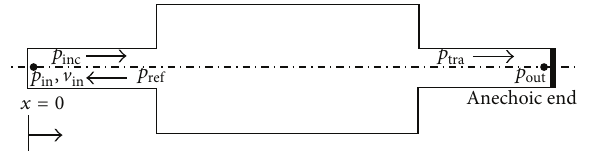
Figure 4: Theory for TL calculation.